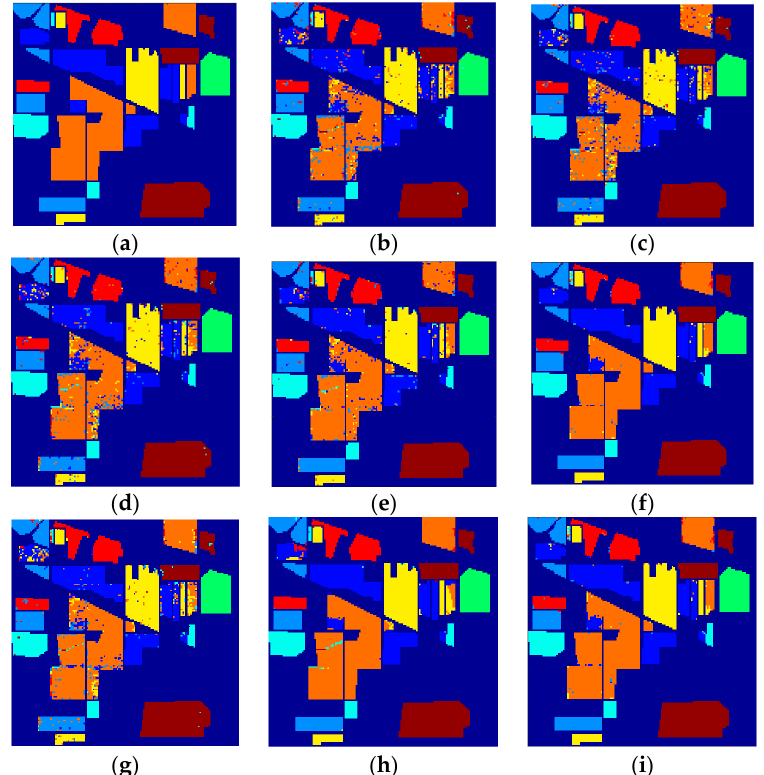
Figure 12. The classification maps obtained via different algorithms in Indian Pines: ( a ) Ground truth; ( b ) SVM; ( c ) RBFNN; ( d ) O_DBN; ( e ) SVM_TFE; ( f ) RBFNN_TFE; ( g ) CNN; ( h ) EFP-G-c; and ( i ) the proposed framework.